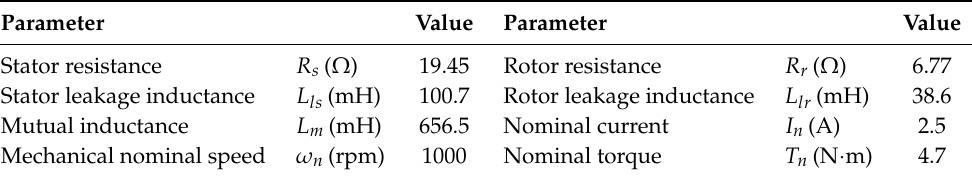
Table 1. Estimated parameters of the